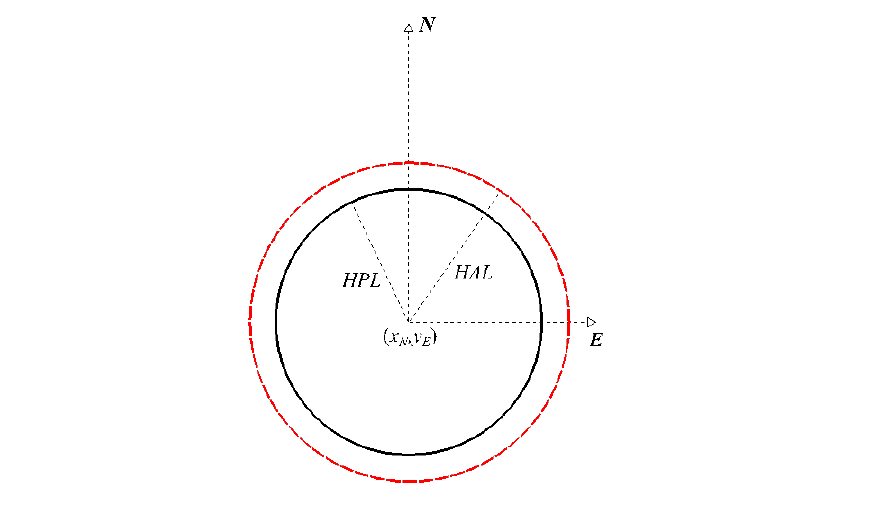
Figure 3. Horizontal protection level and alert limit.